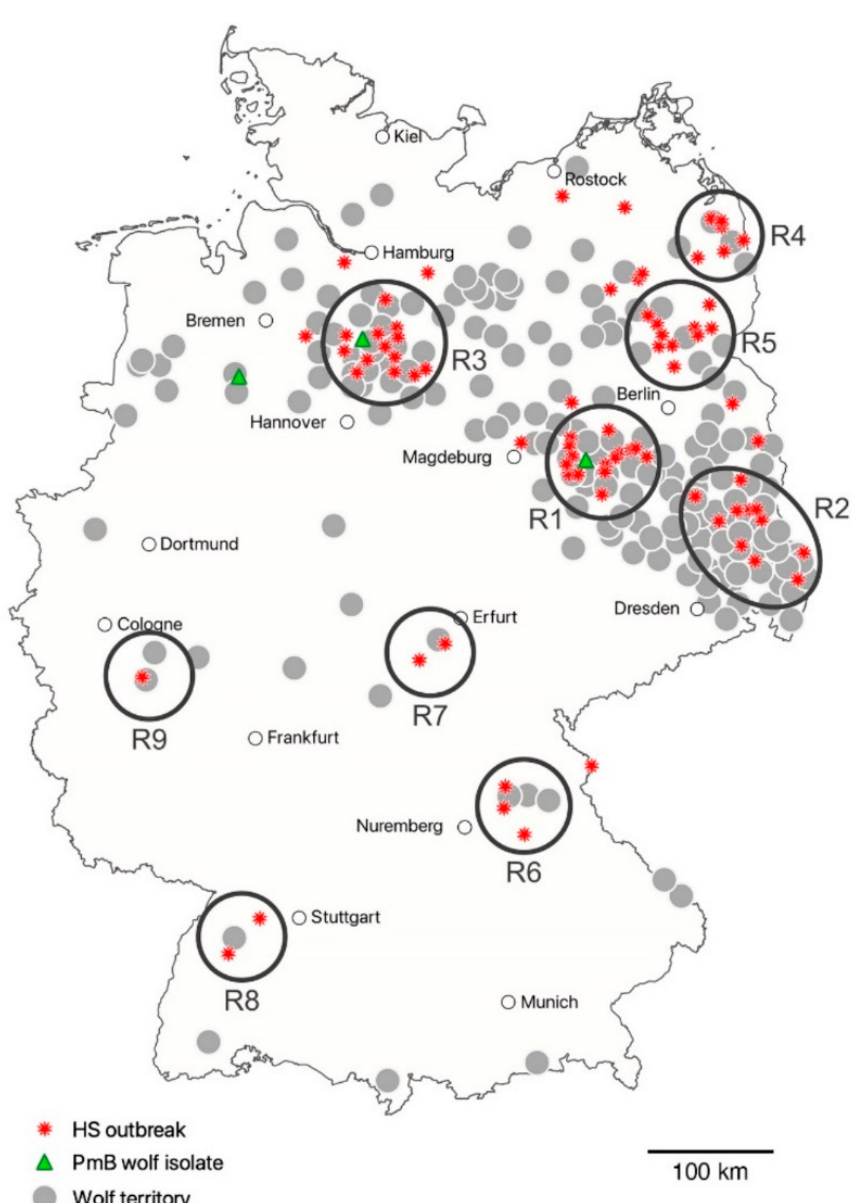
Figure 1. Location of 83 German HS outbreak sites (2010–2019) in relation to proven wolf territories. Regional outbreak clusters R1–R9 are indicated by black circles.